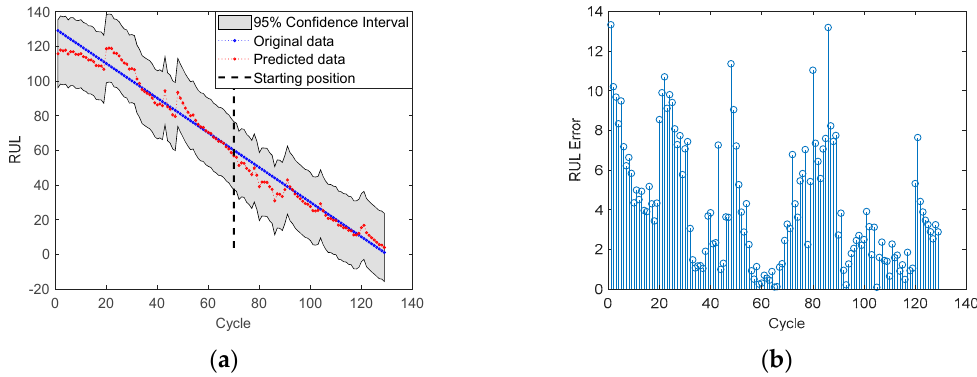
Figure 14. RUL prediction results for battery No. 5 with SP = 71: ( a ) RUL; ( b ) RUL prediction Error.